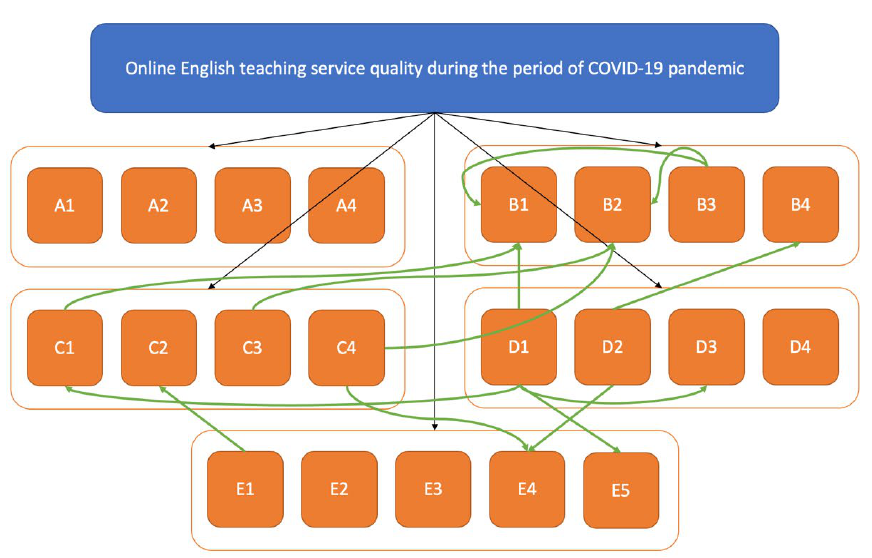
Figure 3. Dependency chart of